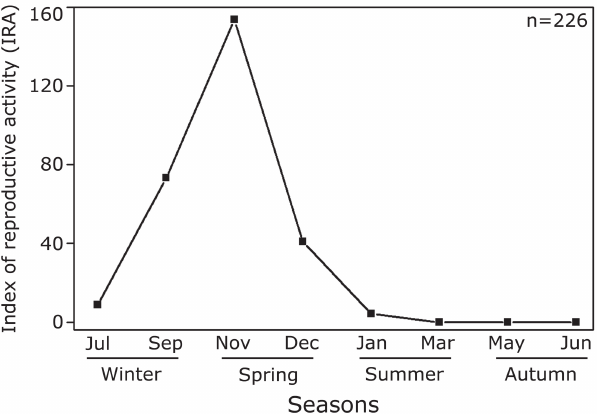
Fig. 6. Variation of the index of reproductive activity (IRA) for female Cetengraulis edentulus among months and seasons in Guanabara Bay.